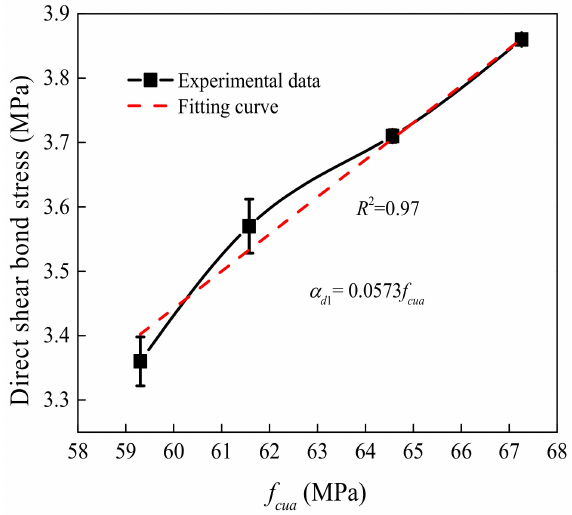
Figure 9. Effect of the ESS-HPC and OCS compressive strength grade on shear bond